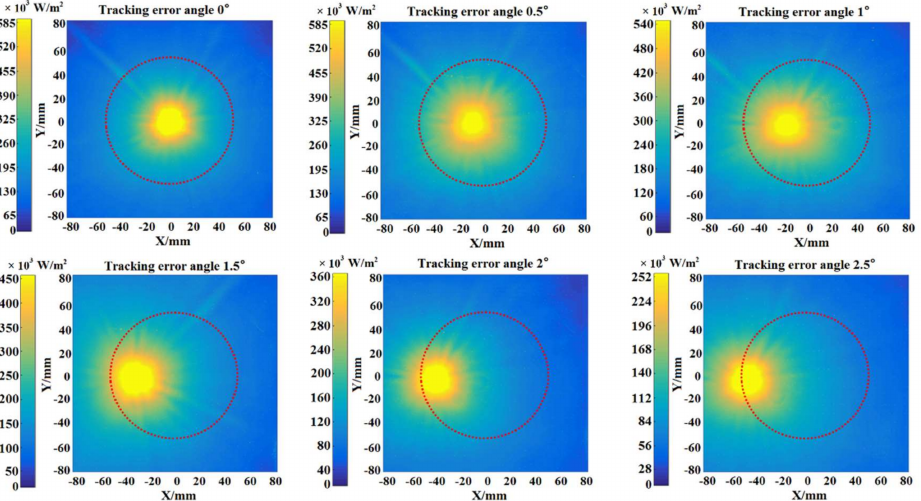
Figure 5. The flux density distributions of focal spot under different tracking error angles.